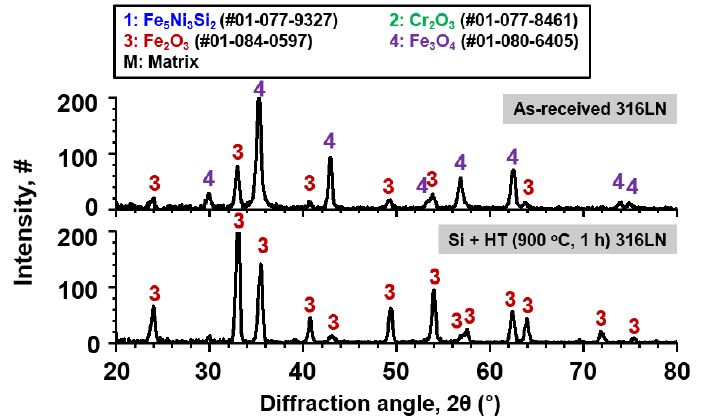
Figure 11. Result of XRD analysis conducted on the as-received and surface-modified SS 316LN after exposure to steam at 650 °C (0.1 MPa) for 500 h.